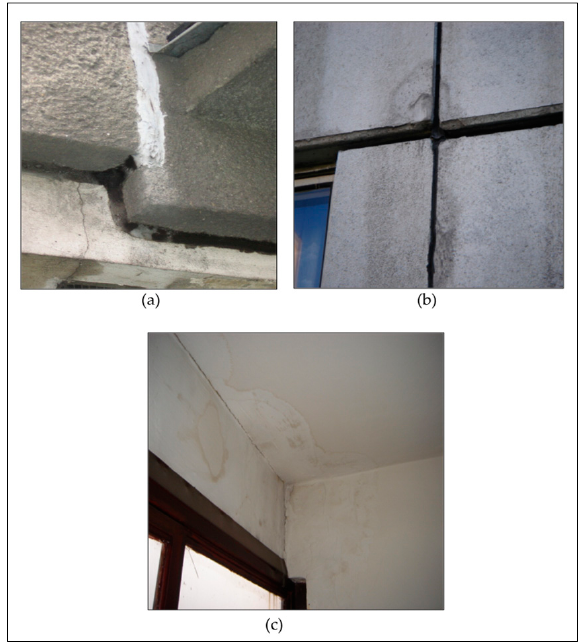
Figure 5. Condition of prefabricated panel sections before the application of ETICS: ( a ) non-compliance with dimensional tolerances in the production of external wall sections; ( b ) non-compliance with technological rules during assembly; ( c ) leakage through the external wall prefab section joints (photo source: Author’s archive [29,30]).